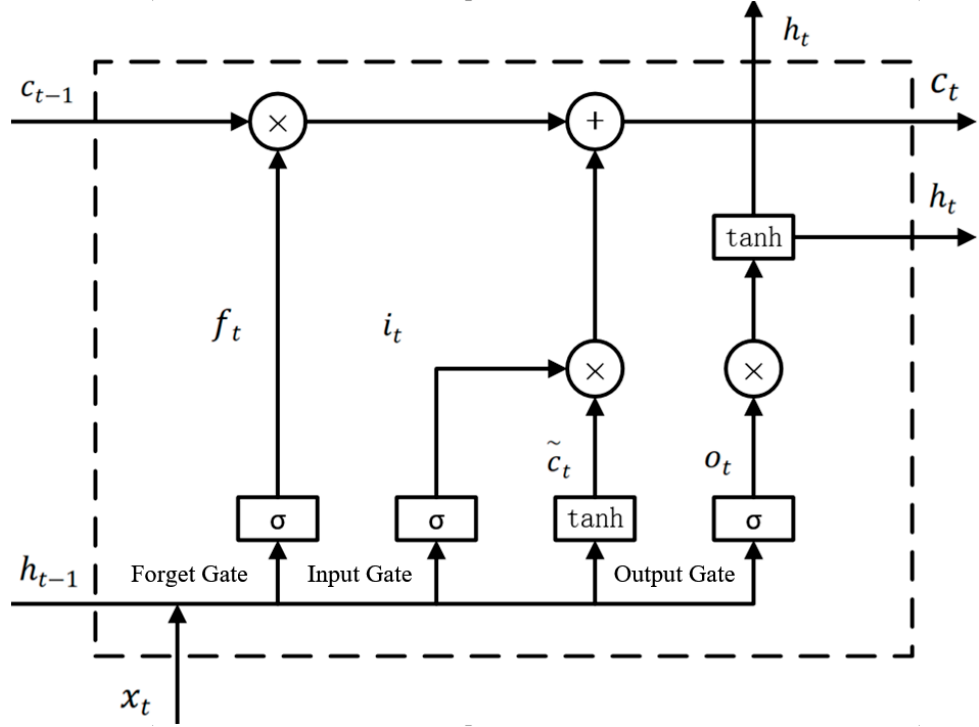
Figure 1. Memory unit structure of LSTM.